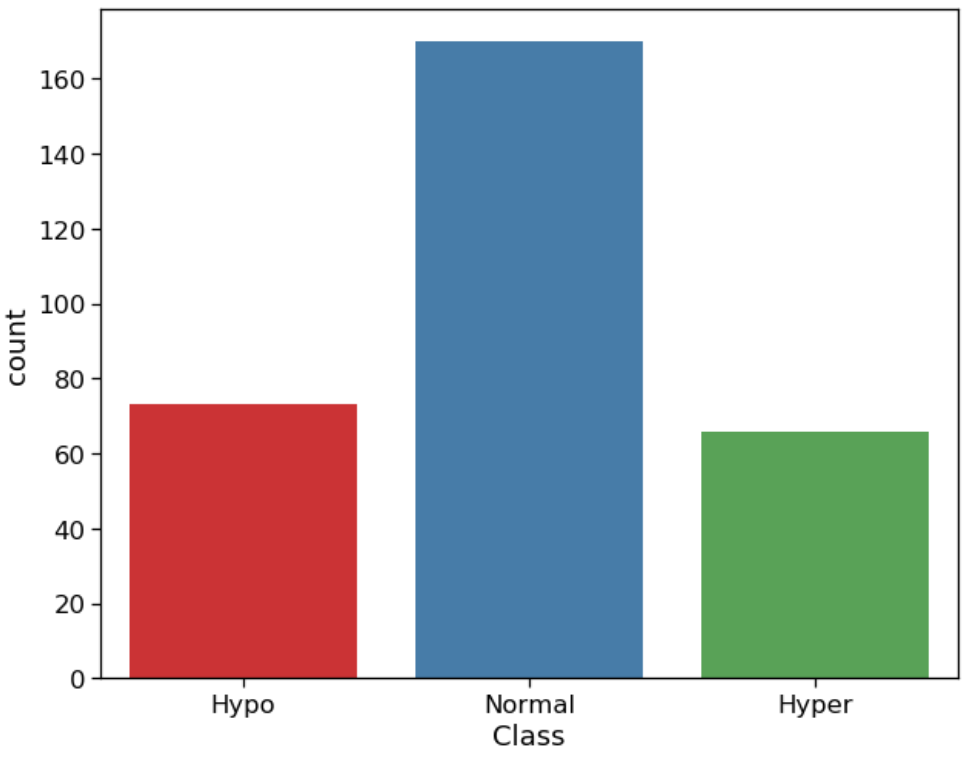
Figure 2. Details of the ‘Class’ variable categories of the dataset.